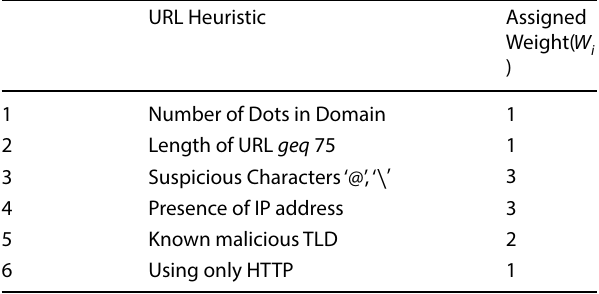
Table 4 URL Heuristics and their assigned weight